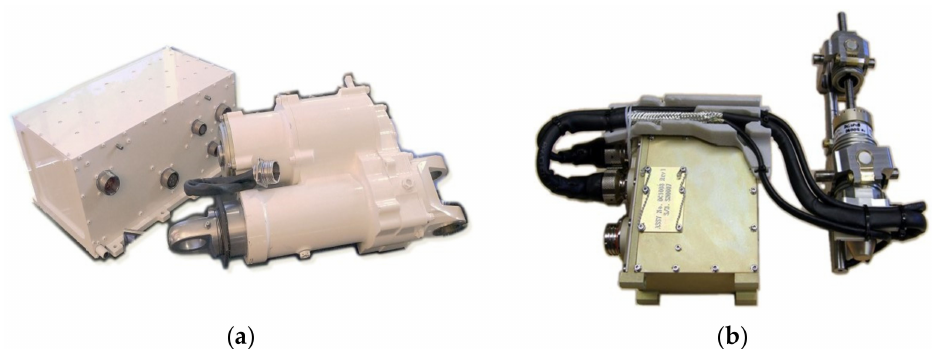
Figure 16. Electronics vs. Actuator space envelopes for EMA: ( a ) Spoiler EMA of the Boeing 787 (one electronic box for 2 actuators); ( b ) EMA for Individual Blade Control, Project 0